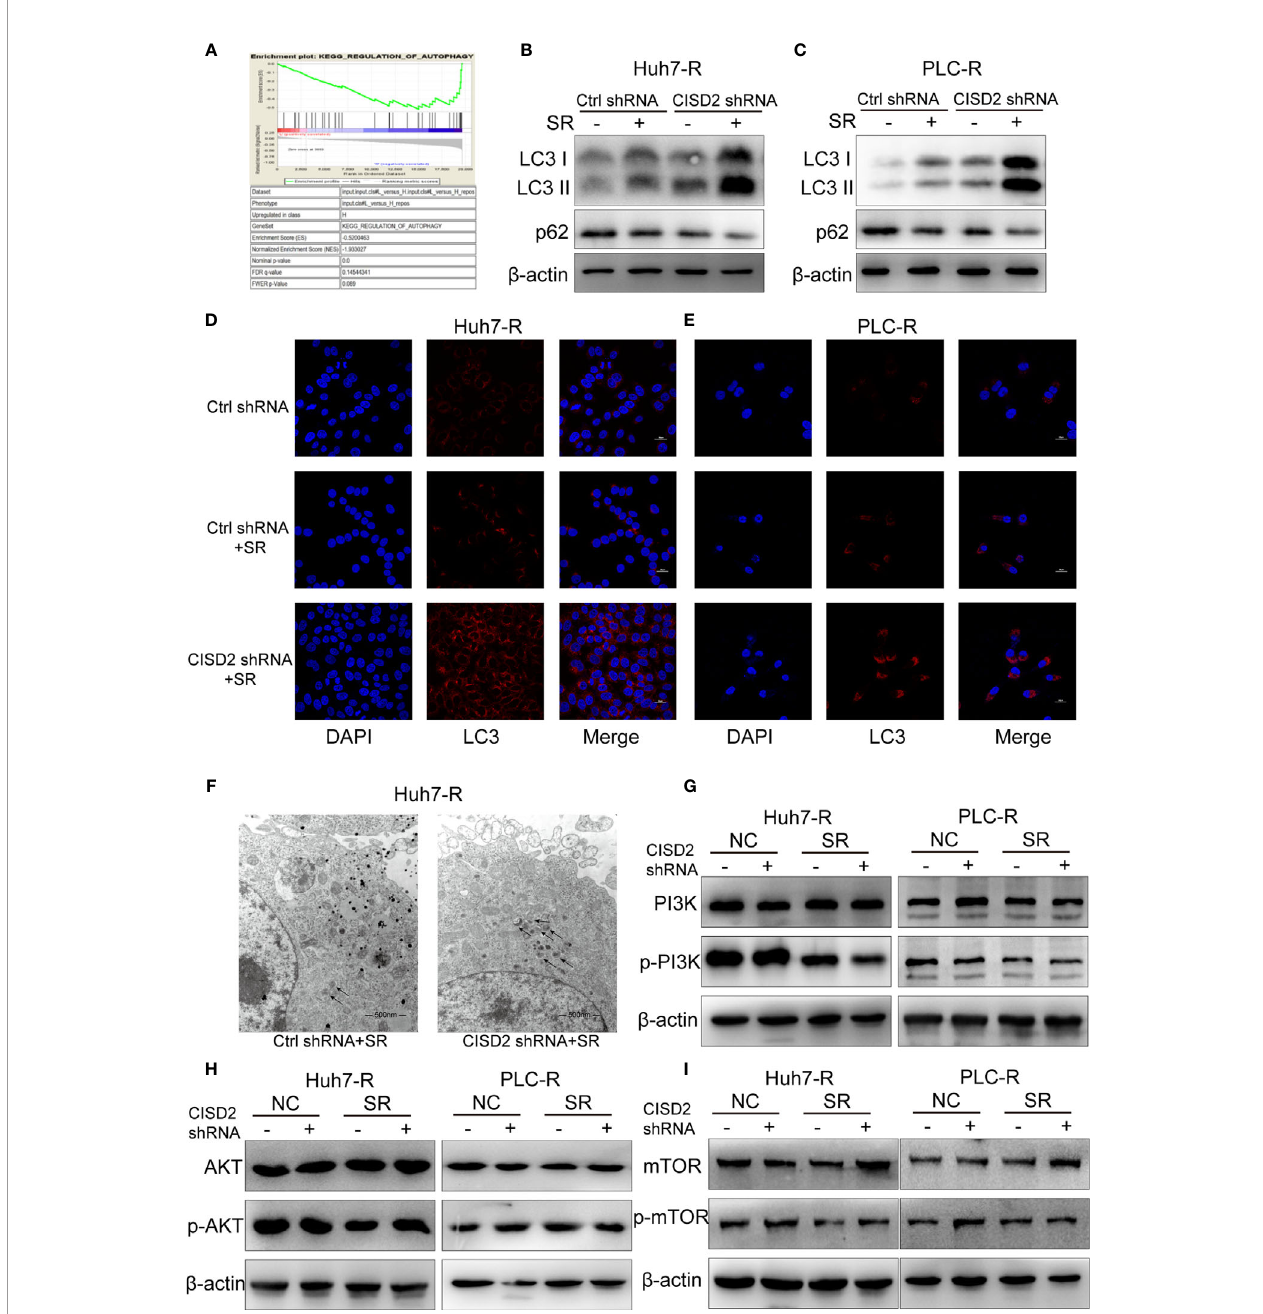
FIGURE 5 | Knockdown of CISD2 promotes autophagy in sorafenib-resistant cells. (A) GSEA was used to detect the function of CISD2. (B, C) Western blot was used to detect the expression level of LC3 and p62 under treatment with sorafenib (10 m mol) or transfected CISD2 shRNA in resistant cells. (D, E) Immuno fl uorescence was used to detect the expression of LC3 under treatment with sorafenib (10 m mol) or transfected CISD2 shRNA. (F) Transmission electron microscopy was used to detect the number of autophagosomes under treatment with sorafenib (10 m mol) or transfected CISD2 shRNA. (G – I) Western blot was used to detect the expression level of PI3K, p-PI3K, AKT, p-AKT, mTOR, p-mTOR under treatment with sorafenib (10 m mol) or transfected CISD2